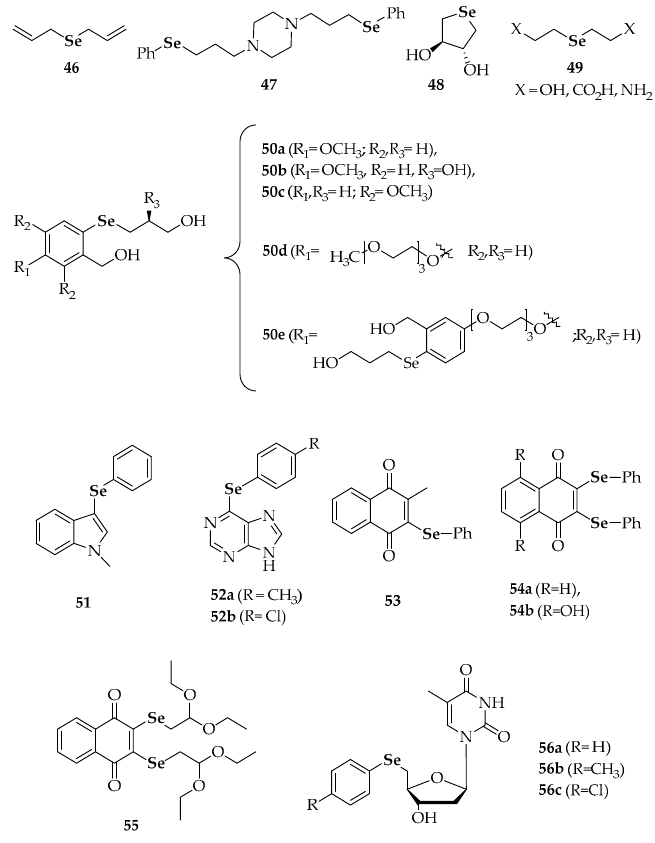
Figure 6. Synthetic selenides with antioxidant studies [83–92].